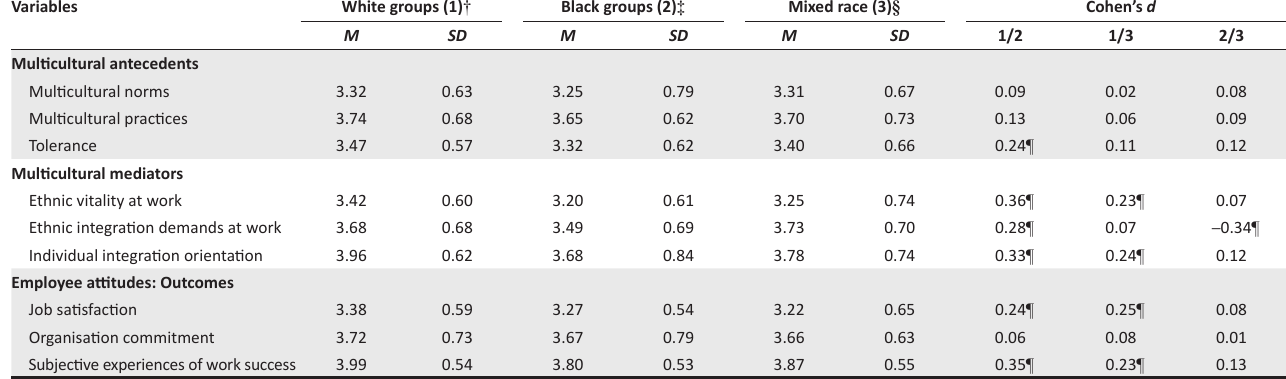
TABLE 5: Means and standard deviations per scale for the different ethnic groups. Variables White groups (1) † Black groups (2)